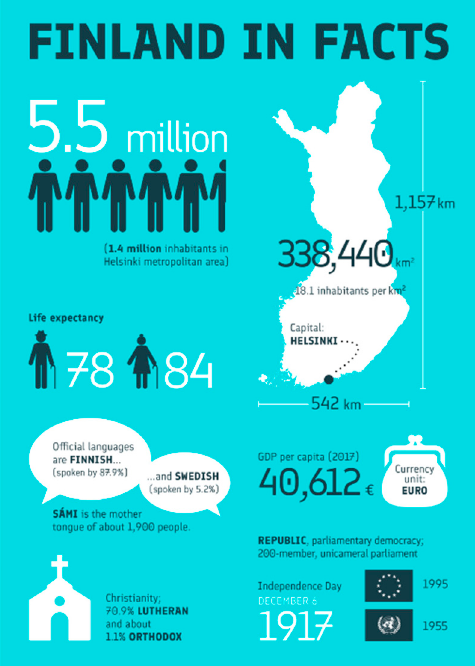
Figure 1. Facts about Finland (This is Finland 2018).